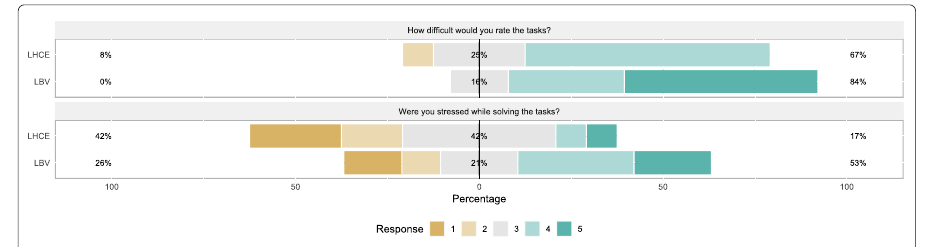
Fig. 16 Level of difficulty and stress perceived during the